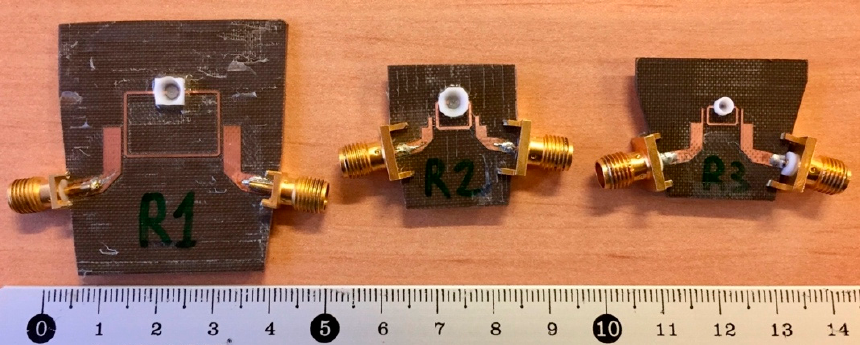
Figure 2. Sensors R1, R2, and R3 used in this study. The scale is in cm.